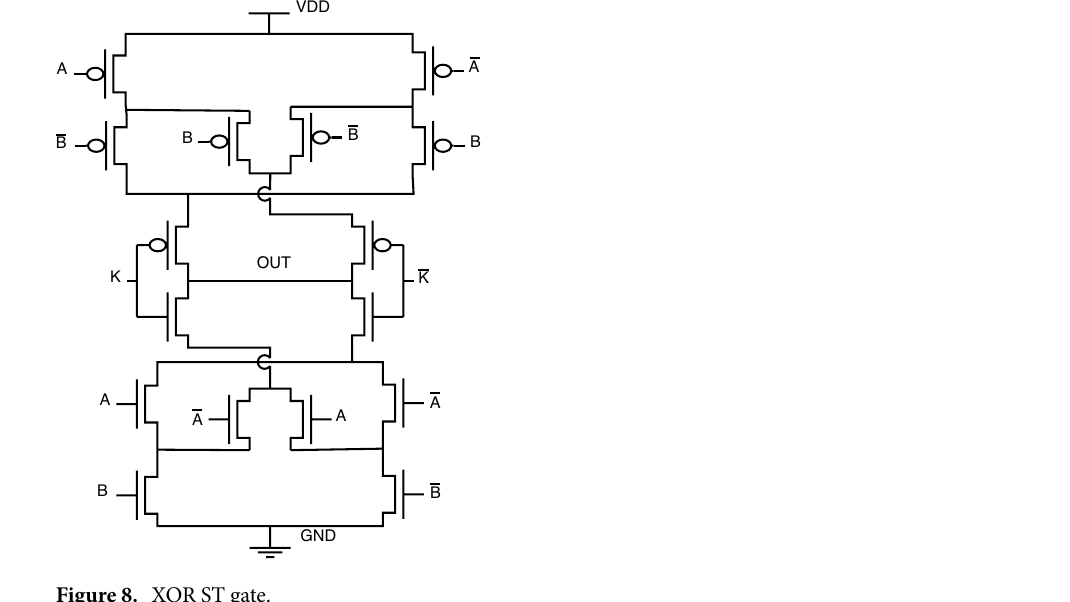
Figure 8. XOR ST gate.